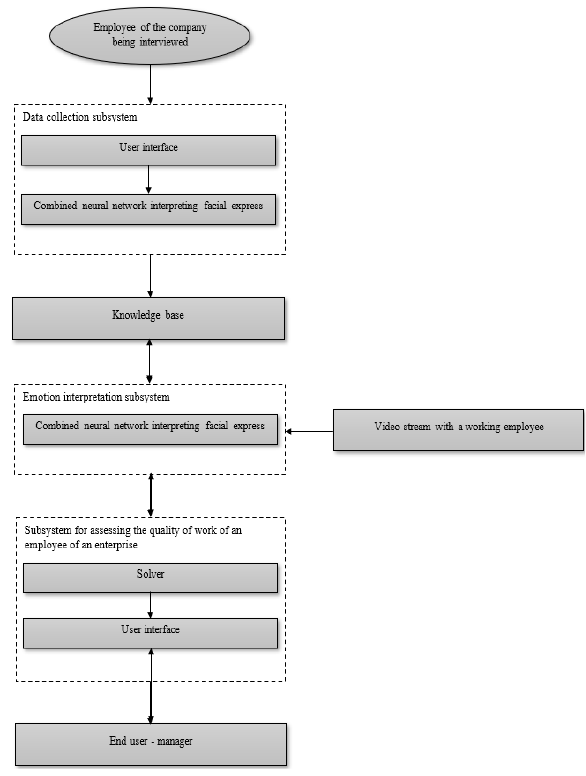
Fig. 1. General structure of the developed expert system